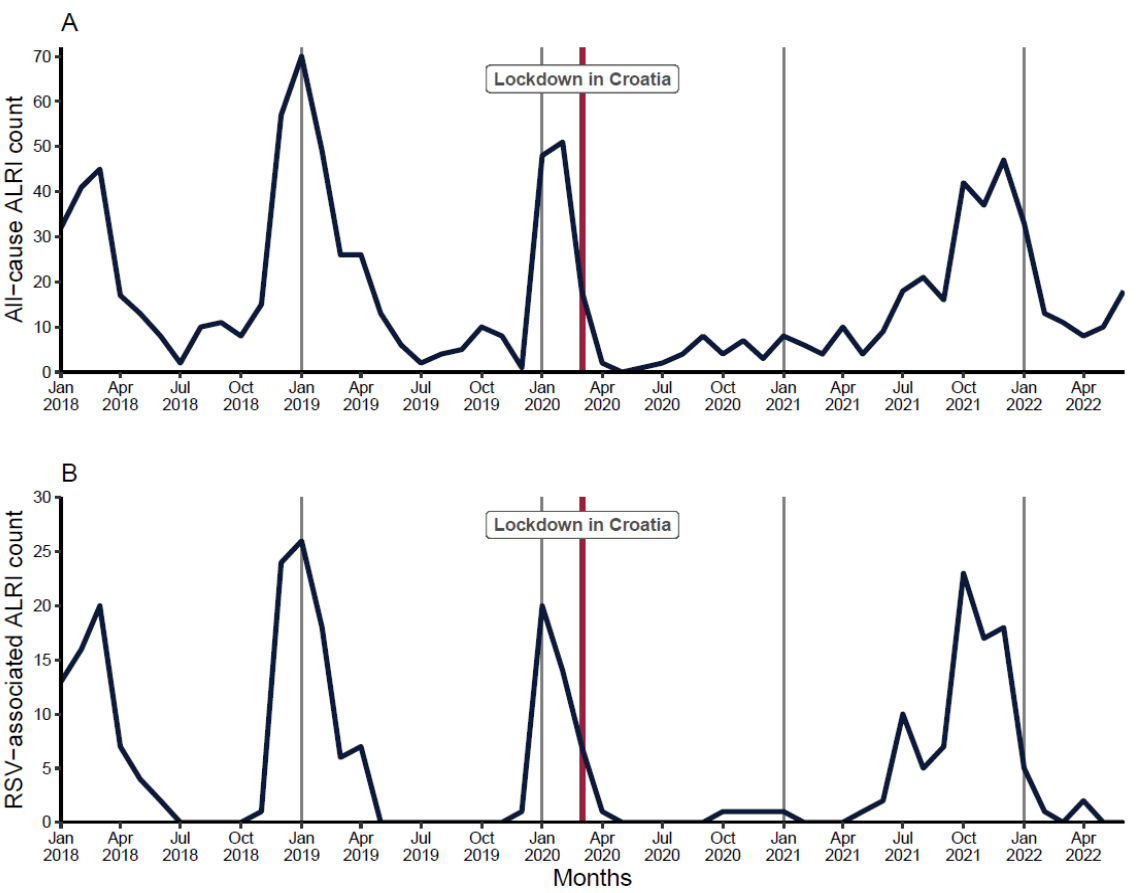
Figure 2. Month-by-month distribution of hospitalizations due to all-cause (panel A ) and RSV-associated (panel B ) ALRI. Black line: Number of hospitalizations. Red vertical line: Lockdown in